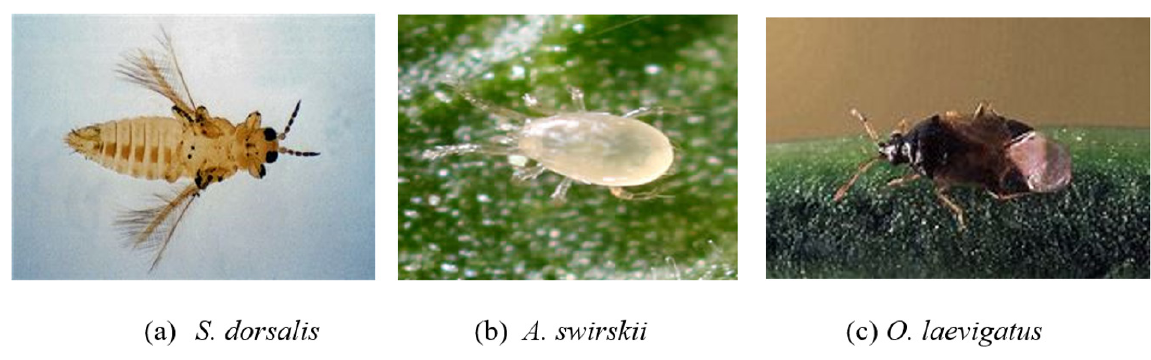
Figure 1 : Chilli thrips (a) and their biological agents (b,